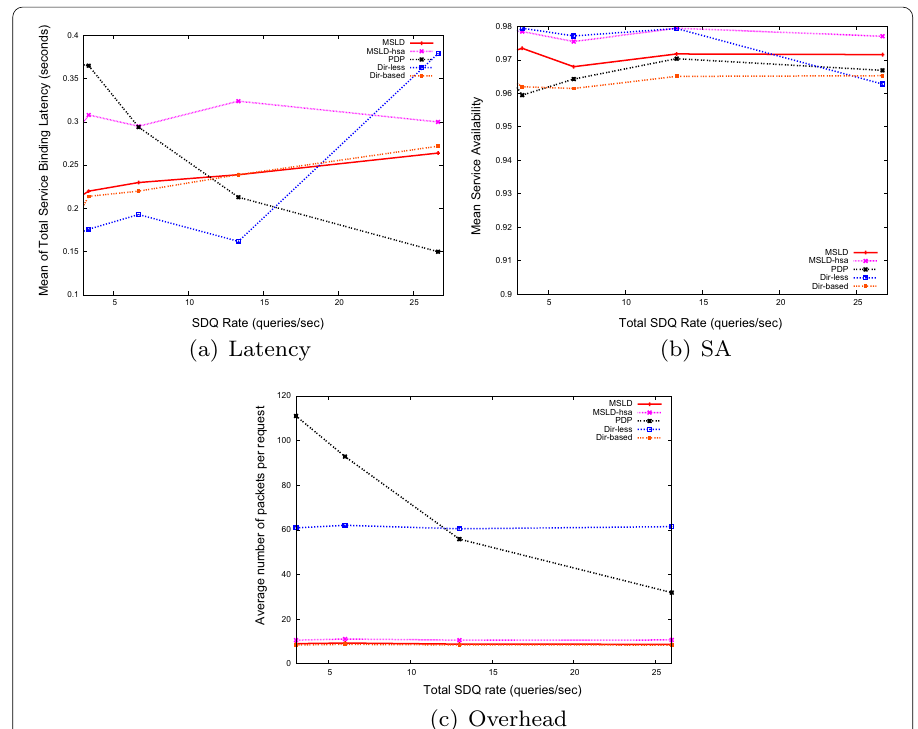
Fig. 3 SD protocols performance versus SDQ rates. Figure shows that As the number of SDQ messages in the network increases, no impact (in terms of service availability) was noticed on the Dir‑based and MSLD protocol running in Unicast mode. In case of high SDQ rates, more latency is experienced. Also, results show that PDP performance in terms of latency and overhead improves as the SDQ rates increase